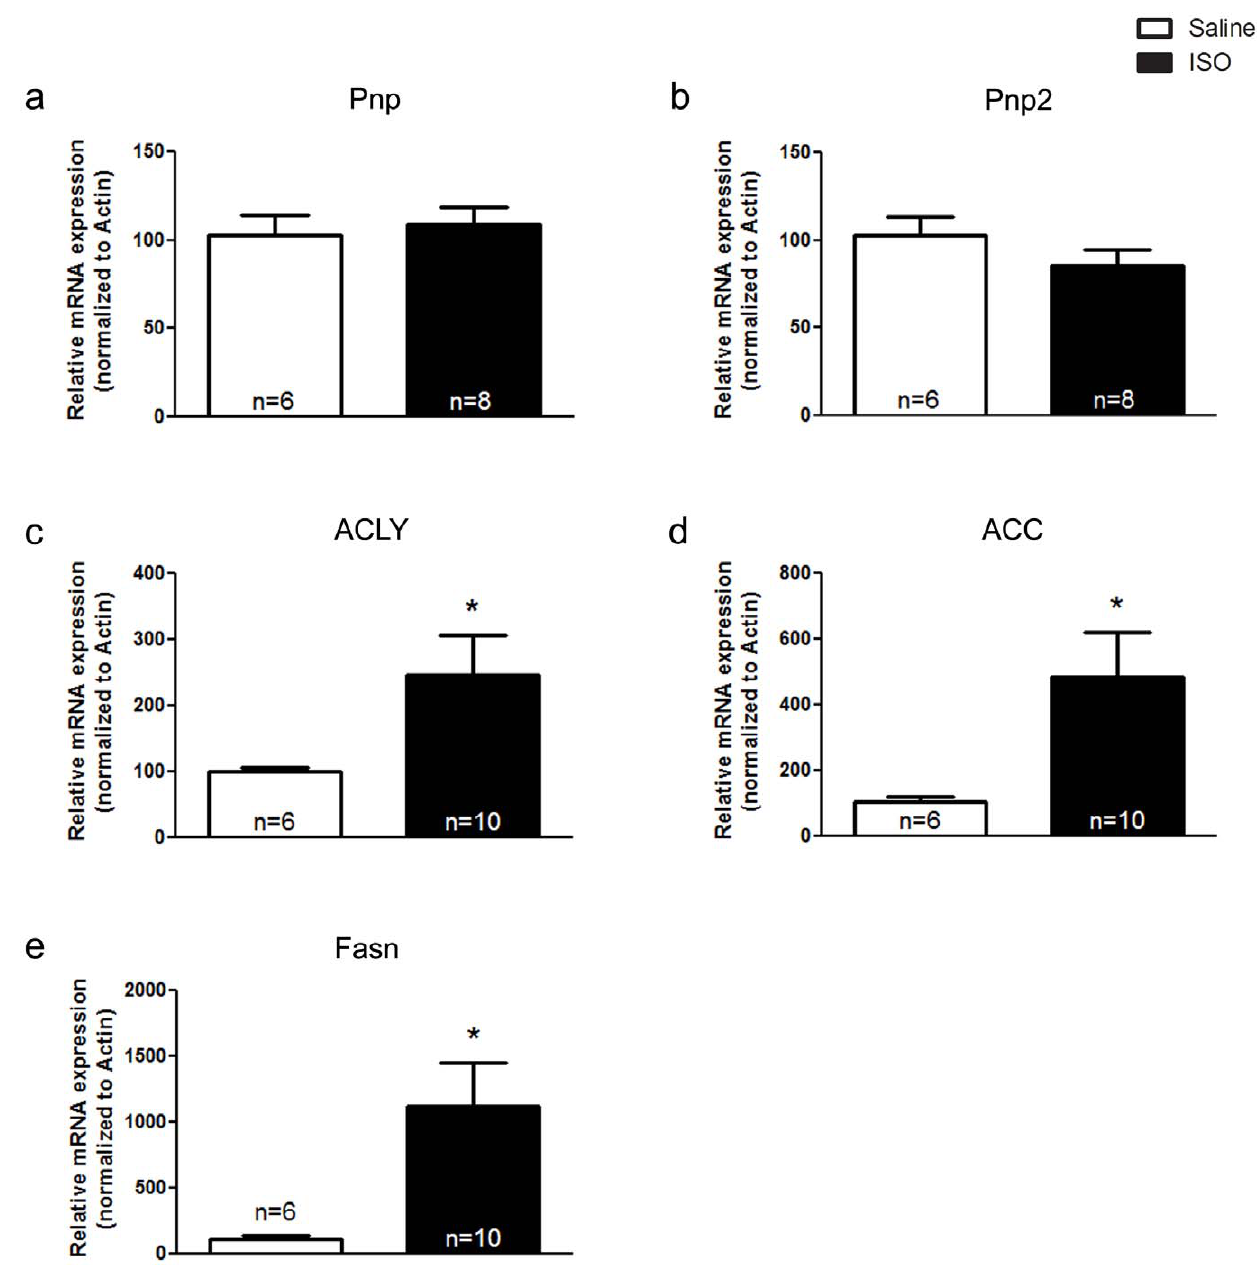
Figure 8. Expression of genes related to fatty acid synthesis is increased following isoproterenol (ISO) treatment. mRNA expression of purine nucleoside phosphrylases (Pnp and Pnp2; panels a and panel b ) were not altered following ISO treatment. ATP citrate lyase (ACLY; panel c ), acetyl-CoA carboxylase (ACC; panel d ) and fatty acid synthase (FAS; panel e ) expression were all significantly increased in ISO-treated mice as compared to saline-treated controls. Data represent the mean 6 SEM, with n indicated within bars. *p , 0.05 versus wild-type mice.